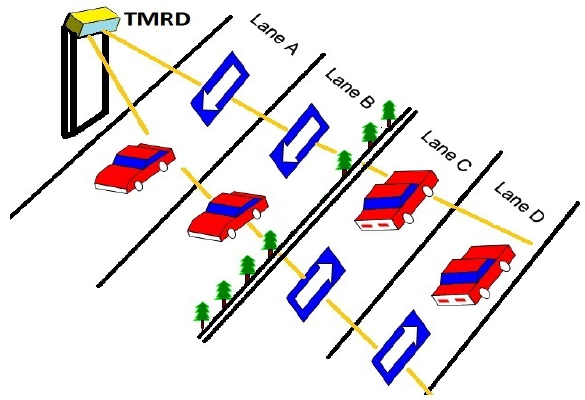
Figure 2. Sideway-looking traffic sensing of the FMCW TMRD.